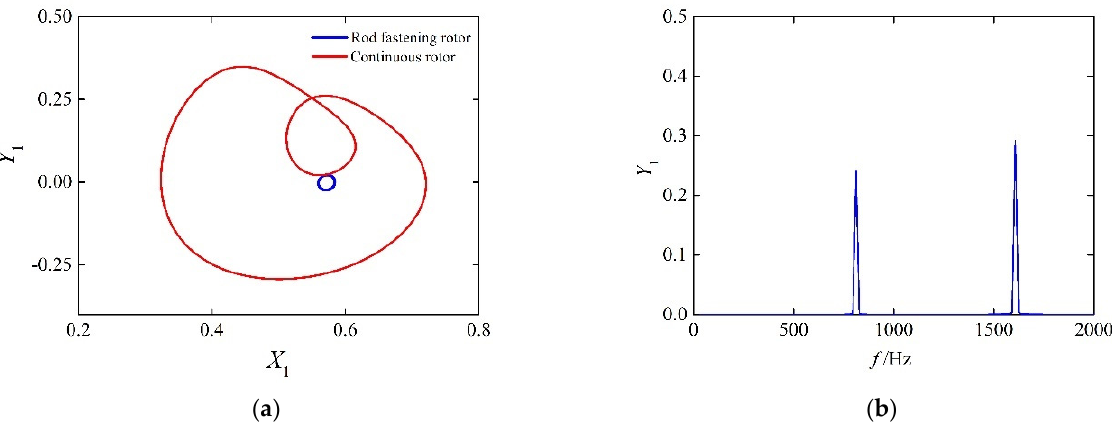
Figure 4. Orbits comparison of the rod–fastened rotor and continuous integral rotor at ω = 1500 rad/s: ( a ) comparison of the orbits at ω = 1500 rad/s; ( b ) spectrogram of the continuous integral rotor at ω = 1500 rad/s.